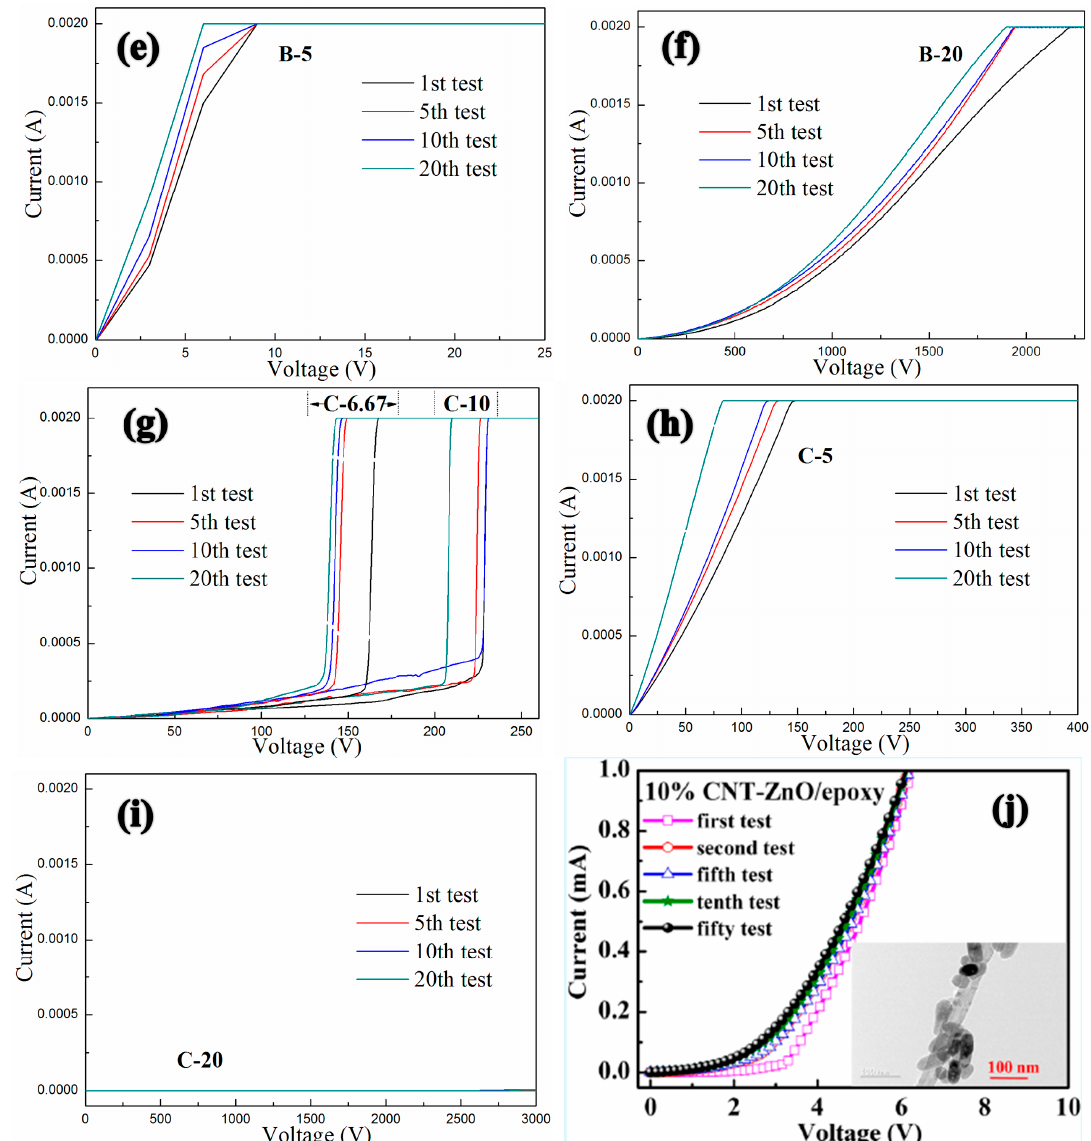
Figure 9. Conductive characteristics of the three groups of GNPs-CNTs-ZnO/ER samples: ( a–c ) with 1:1 weight ratio of GO to MWCNTs, ( d–f ) with 1:2 weight ratio of GO to MWCNTs, ( g–i ) with 2:1 weight ratio of GO to MWCNTs, and ( j ) the composite fabricated by Yu et